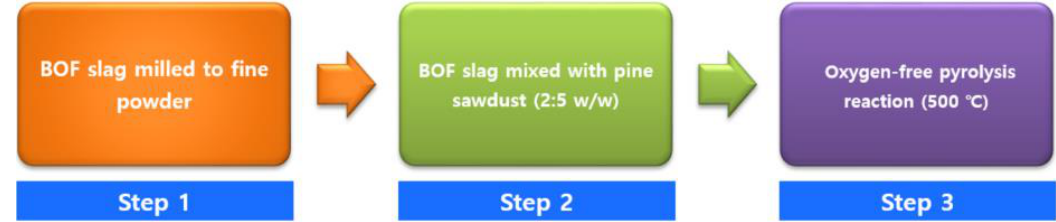
Figure 1. Preparation of MSSB from BOF slag and pine sawdust.